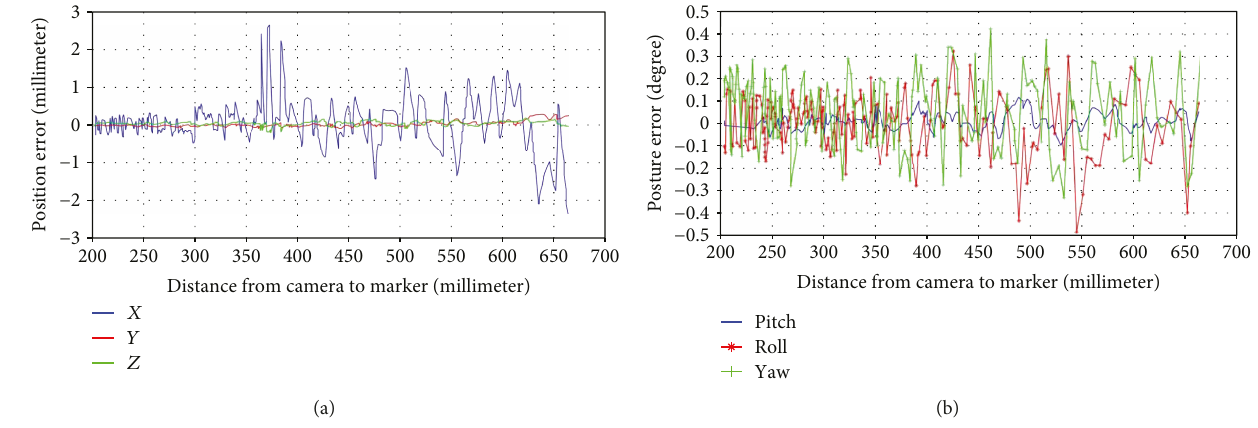
Figure 17: Pose error of vision measurement: (a) position error and (b) posture error.